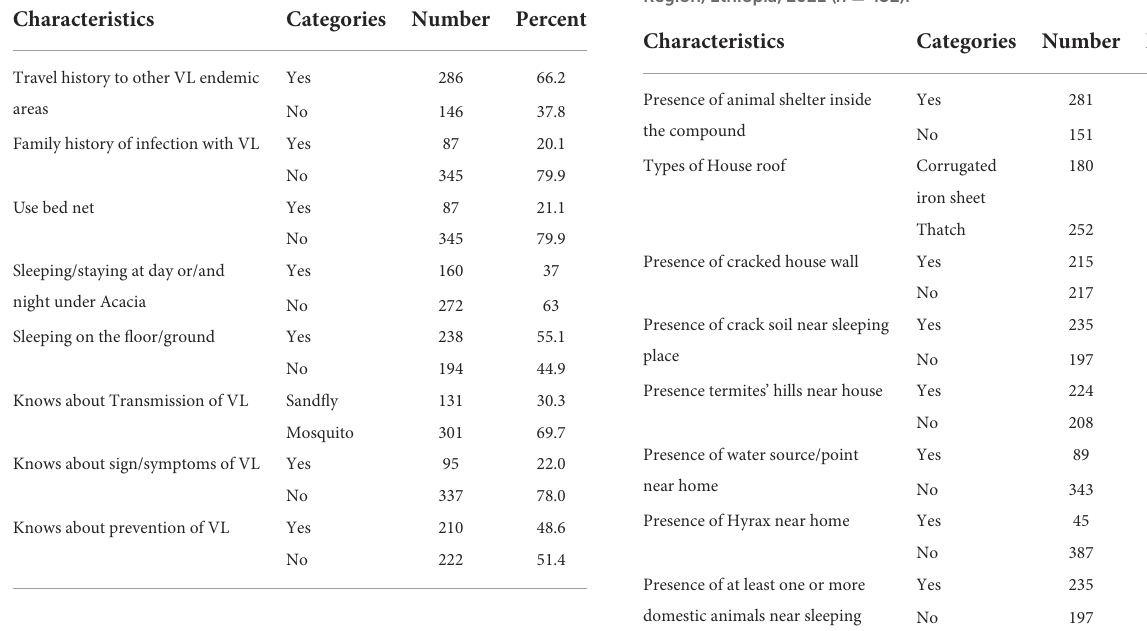
TABLE 2 Behavioral related factors among study participants of Dire District, Borena zone, Oromia Region, Ethiopia, 2021 ( n = 432).